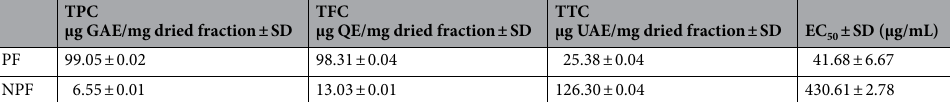
Table 3. Total phenolic, flavonoid, and triterpene content of the polar and non-polar fractions of I. confusa underground parts and their DPPH scavenging activity. *Average of three determinations; GAE gallic acid equivalent, NPF non-polar fraction, PF polar fraction, SD standard deviation, TPC total phenolic content, QE quercetin equivalent, TFC total flavonoid content, TTC total triterpene content, UAE ursolic acid equivalent. EC 50 = effective concentration of the sample required to scavenge 50% of the DPPH free